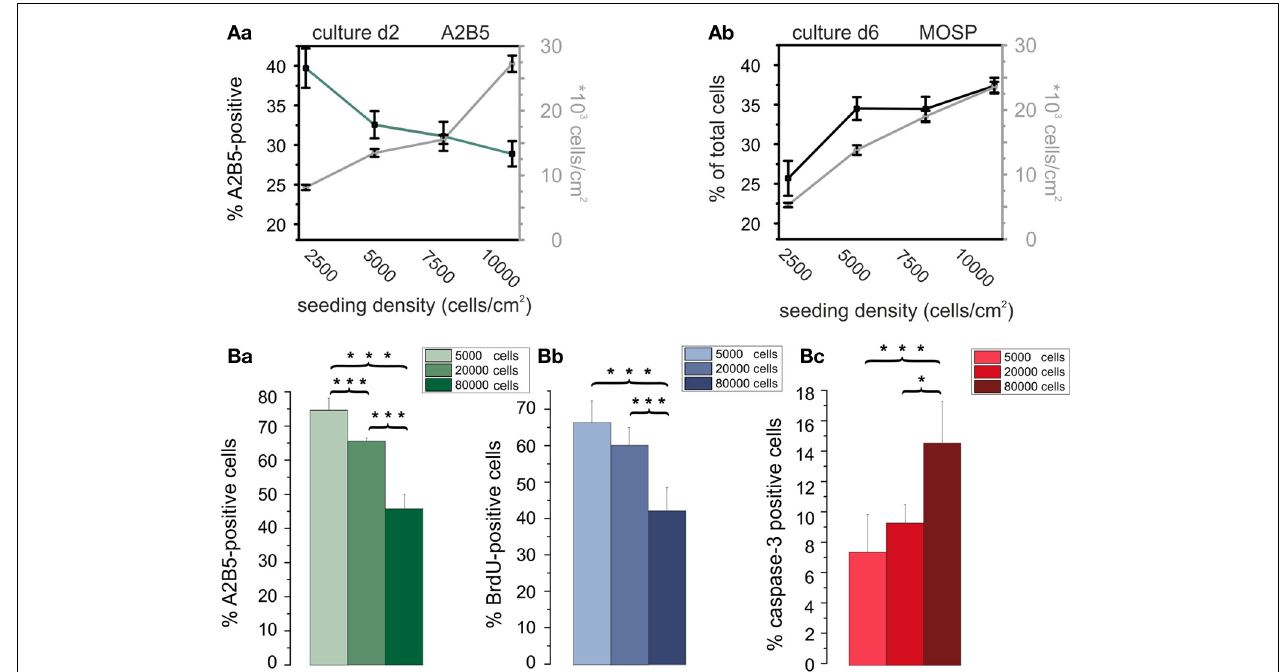
FIGURE 6 | Influence of cell density on differentiation, proliferation, and apoptosis of OPCs. (Aa) Cell density (data connected by gray lines) and percentage of A2B5-positive cells (data connected by green line) vs. plating density at day 2 in culture. Note, that the percentage of immature OPCs negatively correlates with cell density. (Ab) Total cell density (gray line) and percentage of MOSP-positive cells (black line) vs. cell density after 6 days in differentiation medium. Note the larger percentage of differentiated cells in higher plating density. Data shown in (A) obtained from RPMI based cultures. Data shown in every bar collected from n = 100 frames from 5 preparations. Data for A2B5 as well as MOSP staining between first and last plating